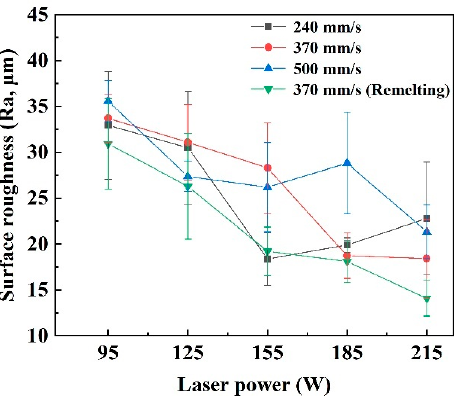
Figure 7. The surface roughness of the blocks formed under different process parameters.